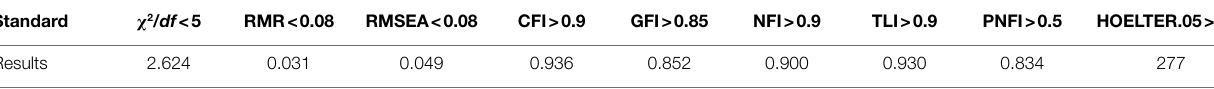
TABLE 4 | Model fit indices of the measurement model.